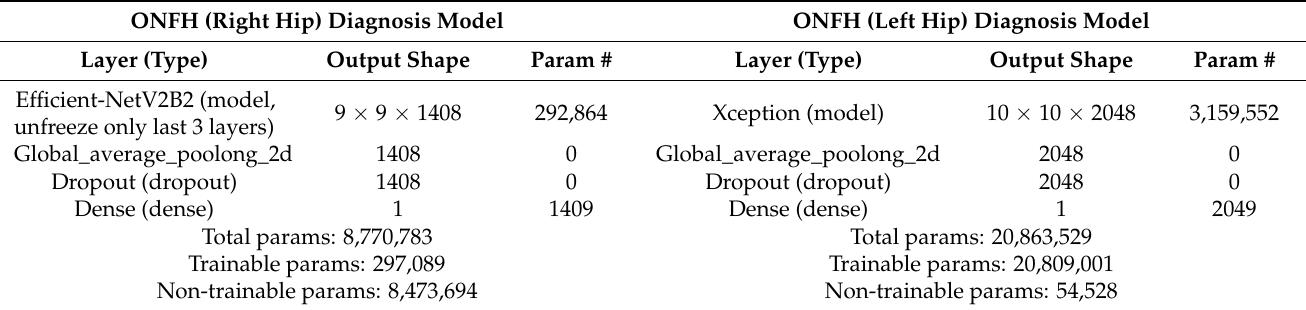
Table 2. Layer types and parameters in osteonecrosis of femoral head (ONFH) diagnosis model. ONFH (Right Hip) Diagnosis Model ONFH (Left Hip) Diagnosis Model